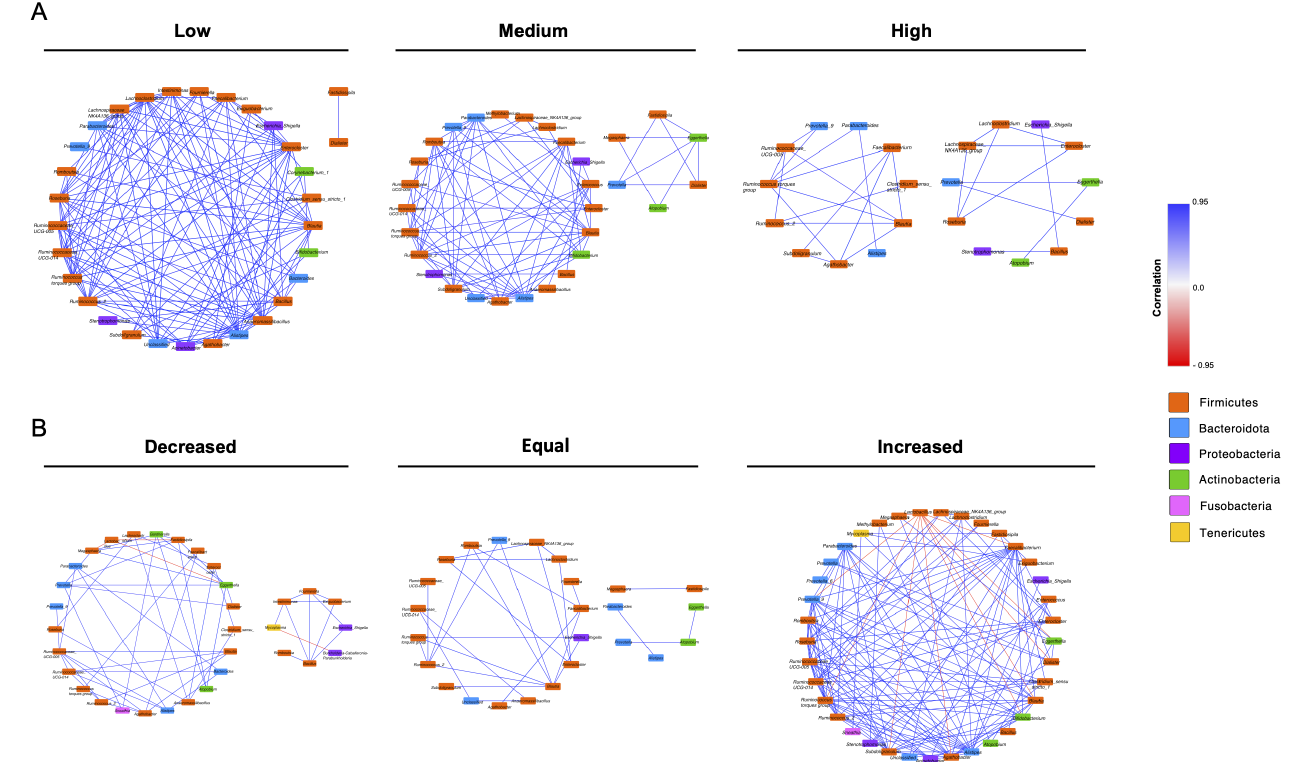
Figure 4. Correlation networks of the 50 most abundant genera of the study population. ( A ) Network visualization of pairwise correlations between genera according to viral load. ( B ) Network visualiza- tion of pairwise correlations between genera according to viral load outcome. Spearman correlation test was used to estimate correlation coefficients. The nodes represent the bacterial genera, and their color represents the phylum to which they belong. Positive correlations are illustrated as blue edges and negative correlations as red edges. The networks only represent significant correlations ( p < 0.05, after FDR correction) with ρ above 0.75 and lower than − 0.75, and that were computed with the Spearman correlation